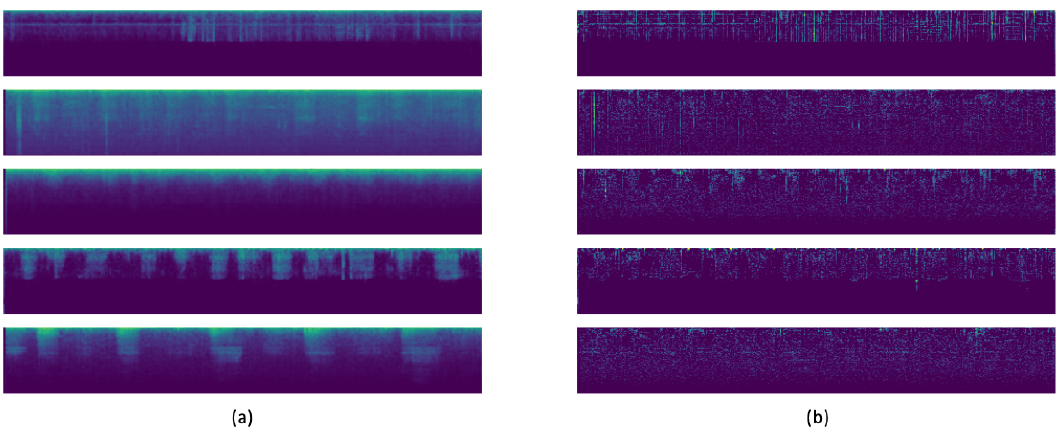
Figure 6. In ( a ), the new images generated using the VAE. In ( b ), the variation between the original and the generated images.